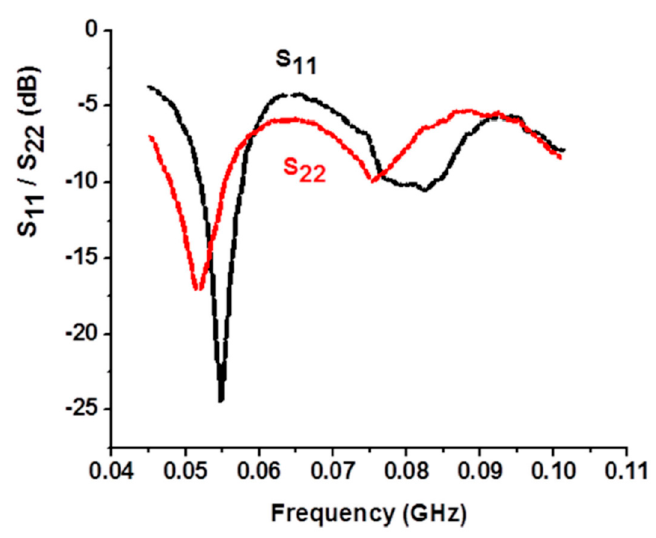
( b ) Figure 9. ( a ) Photo of the underwater test range used in our experiments. The inset shows experimental configuration; ( b ) Contour plot of the link probability measured in seawater as a function of diver depth and distance between the divers. The sea floor was located at 9 m depth. The skin depth at 50 MHz in seawater is shown to the scale. The underwater experiments depicted in Figure 9 were conducted without any external cables,